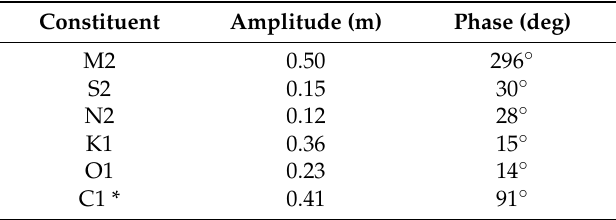
Table 4. Major tidal constituents at Port San Luis, California and calculated C1.